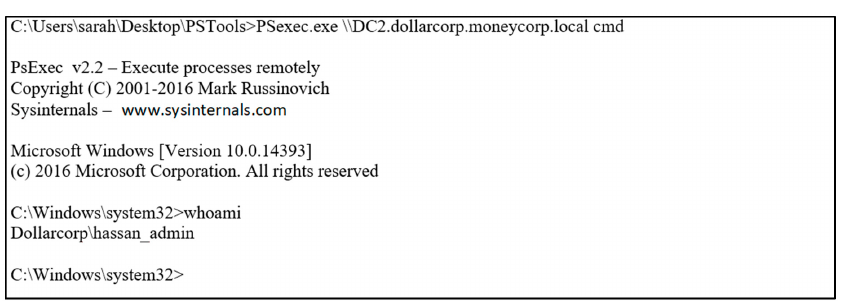
Figure 11. Admin Ticket Issued Successfully.